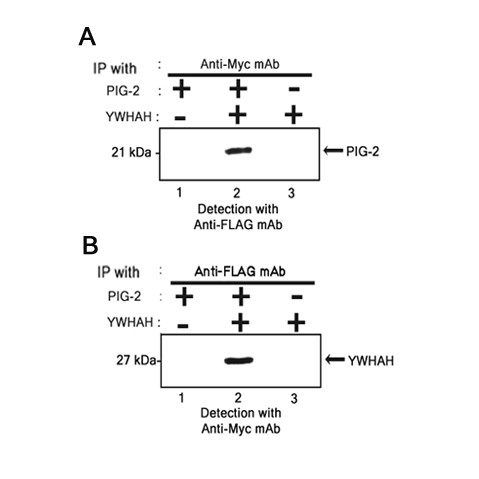
Protein-interaction of PIG-2. (A)PIG-2 binds to YWHAH. Co-immunoprecipitation from transfected HEK 293 cells producing PIG-2 and YWHAH proteins was done. Immunoprecipitation was performed with anti-Myc mAb. The protein in the pellets was detected with anti-FLAG mAb. (B) YWHAH binds to PIG-2. Co-immunoprecipitation from transfected HEK 293 cell lines producing YWHAH and PIG-2 proteins was done. Immunoprecipitation was performed with anti-FLAG mAb. The protein in the pellets was detected with anti-Myc mAb.